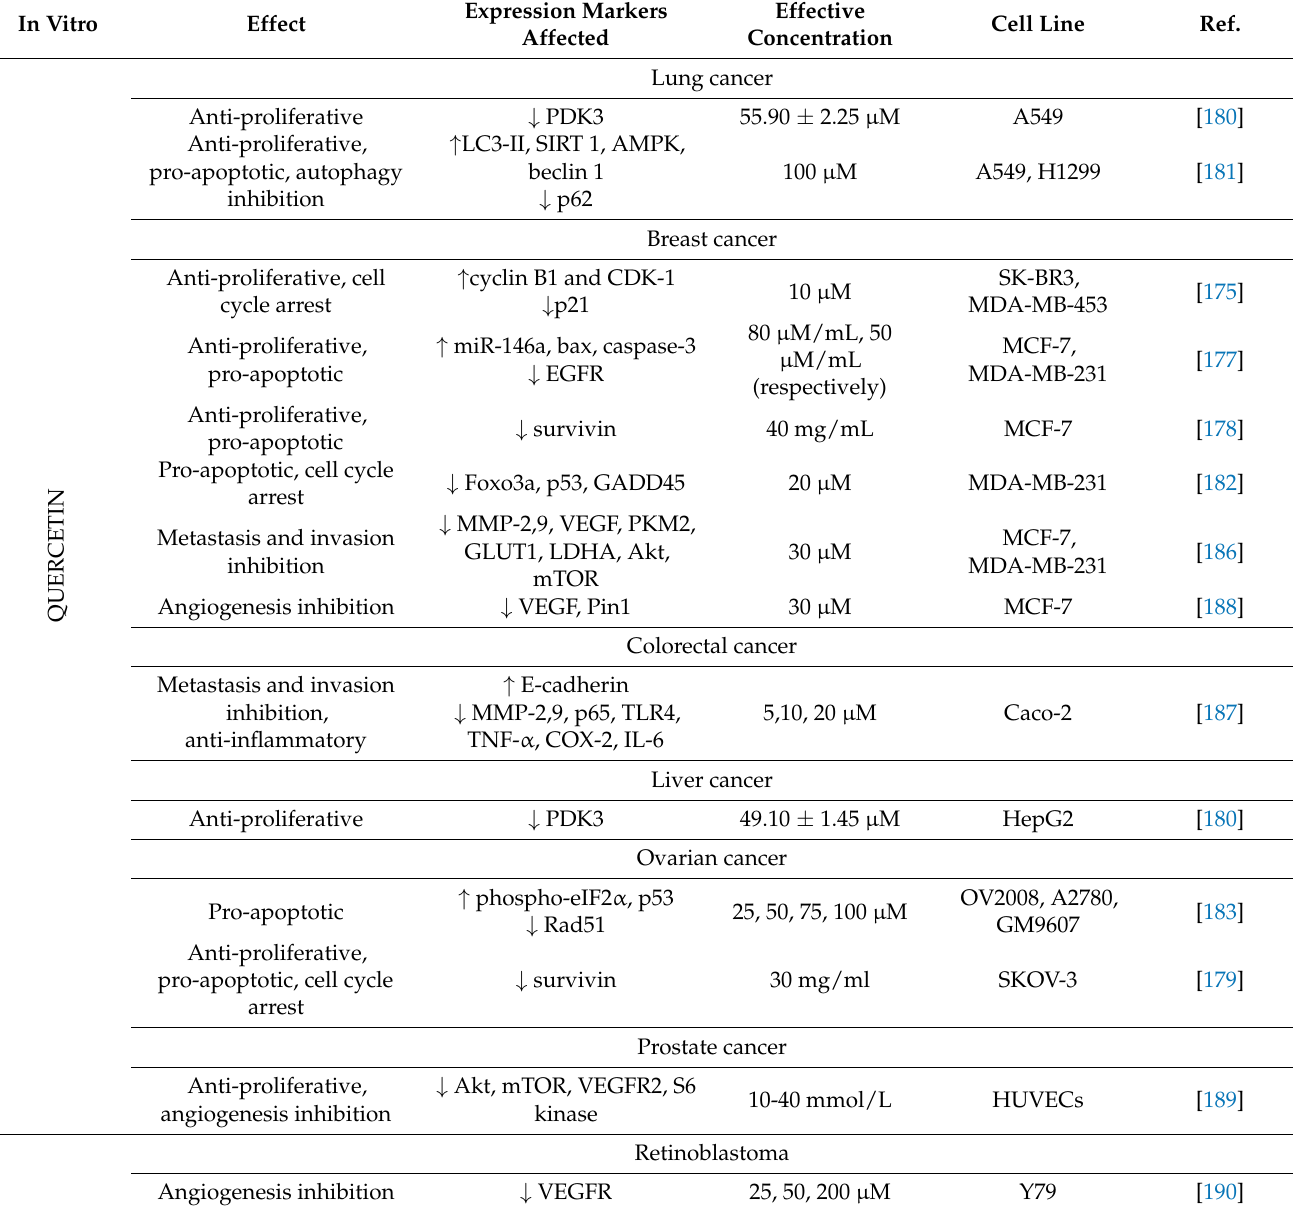
Table 3. Summary of mentioned in vitro studies with the effective